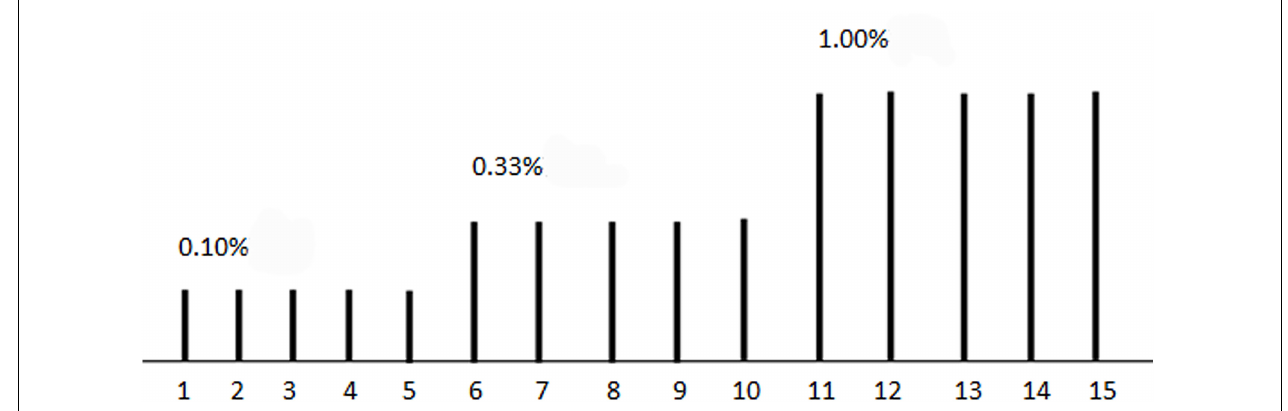
FIGURE 1 | The illustration of olfactory stimuli presenting. Each stimuli lasted for 6 s, followed by a 42-s of clean odorless air, a total of 15 stimulus. 0.10, 0.33, and 1.00% lavender oil were used in the first five, second five, and third five stimulus, respectively.